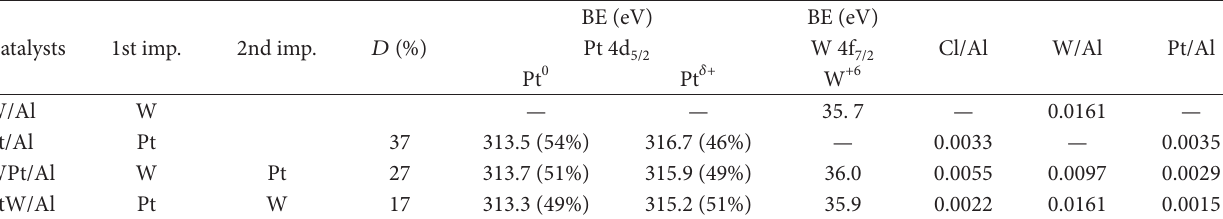
T 1: Catalysts naming convention. Data of dispersion